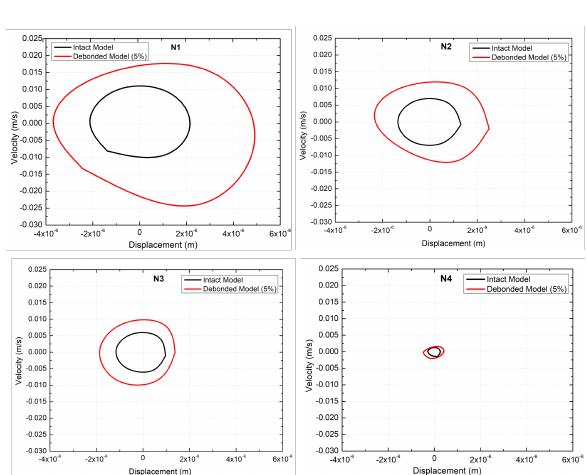
Figure 13: Comparison of phase portrait calculated at various mea- surement points at frequency ratio η